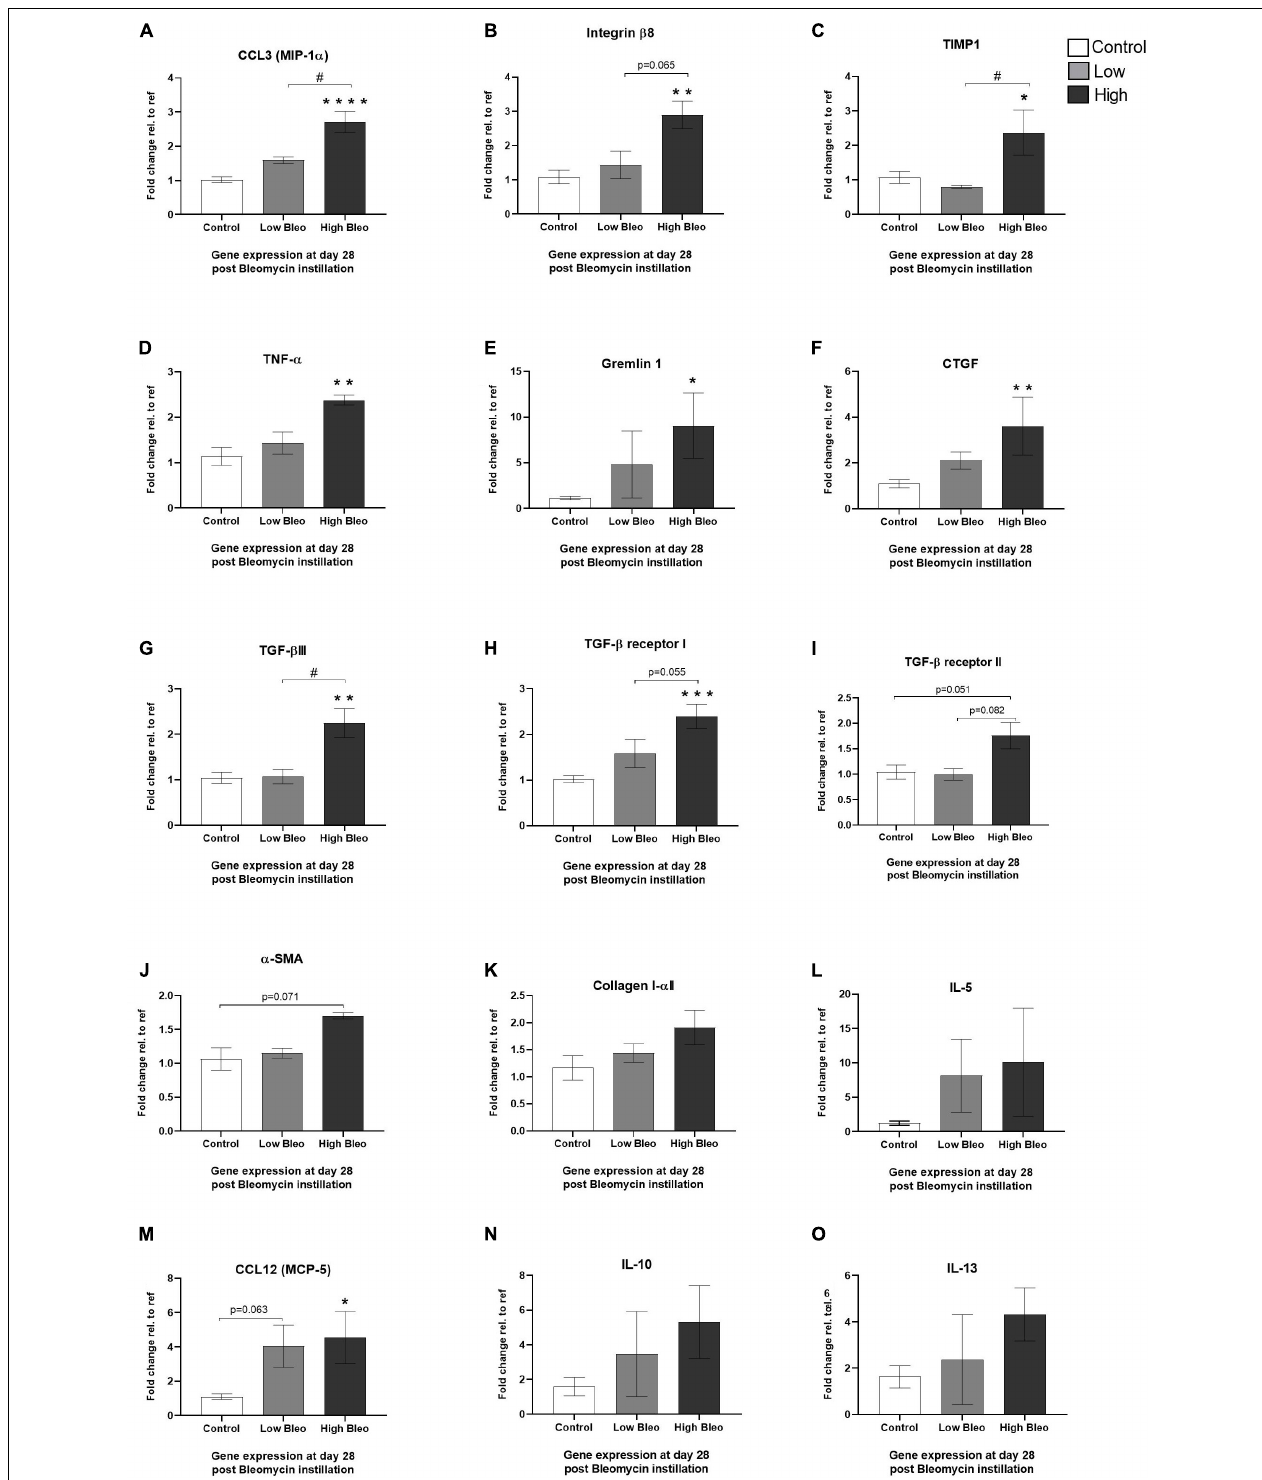
FIGURE 9 | Gene expression at day 28 in samples from high- and low-responder groups. Gene expression of (A) CCL3 (MIP-1 α ), (B) integrin- β 8, (C) TIMP1, (D) TNF- α , (E) gremlin1, (F) CTGF, (G) TGF- β III, (H) TGF- β receptor I, (I) TGF- β receptor II, (J) α -SMA, (K) Collagen I, (L) IL-5, (M) CCL12 (MCP-5), (N) IL-10, and (O) IL-13, are all presented as mean ± standard error of the mean (SEM). All samples from the bleomycin group are related to the mean of control and normalized to the geometric mean of five different reference genes. Each presented group contains n = 3 and are only samples analyzed from the group of rats undergoing longitudinal imaging, being terminated at day 28. Significance is indicated by * when p < 0.05; p < 0.01 by ** and p < 0.001 by ***, when comparing bleomycin towards the saline control. The comparison between bleomycin-challenged groups is expressed as # when p < 0.05 and #### when p < 0.0001.